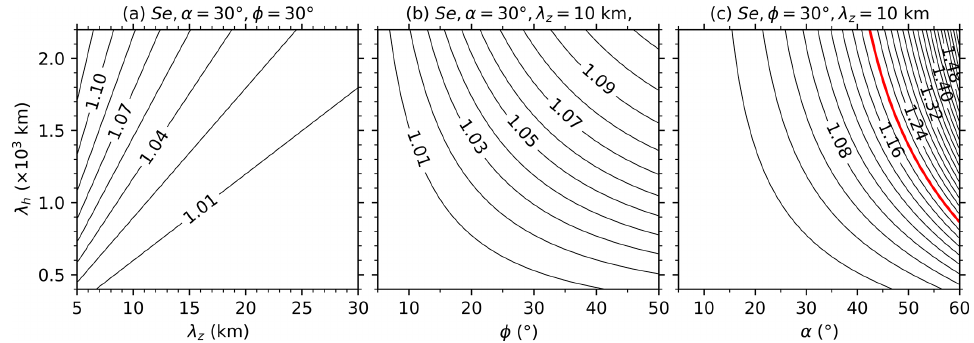
Figure 3. Dependencies of S e on the horizontal and vertical wavelengths for α = 30 ◦ and φ = 30 ◦ (a) , on the latitude φ for α = 30 ◦ and λ z = 10km (b) , and on the angle α for φ = 30 ◦ (c) . The red contour line in (c) indicates S e = 1 . 2. All panels have the same y -axis scale.